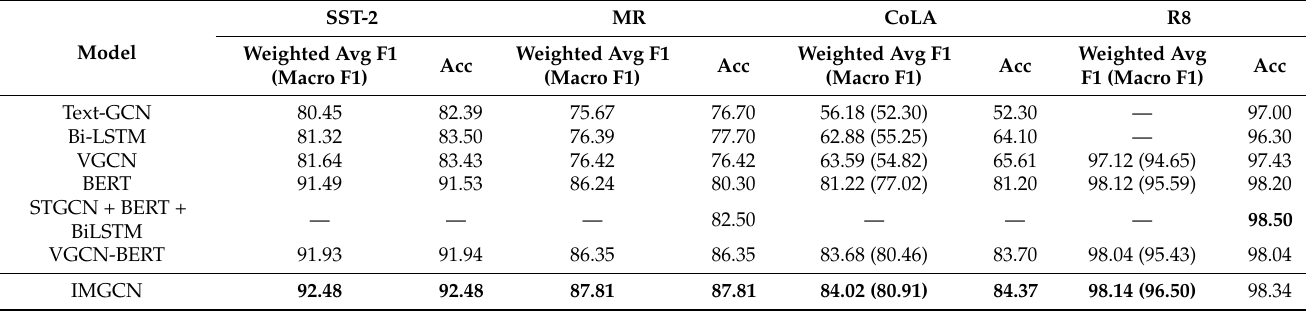
Table 1. Accuracy, Weighted average F1-Score and (Macro F1-score) on the test